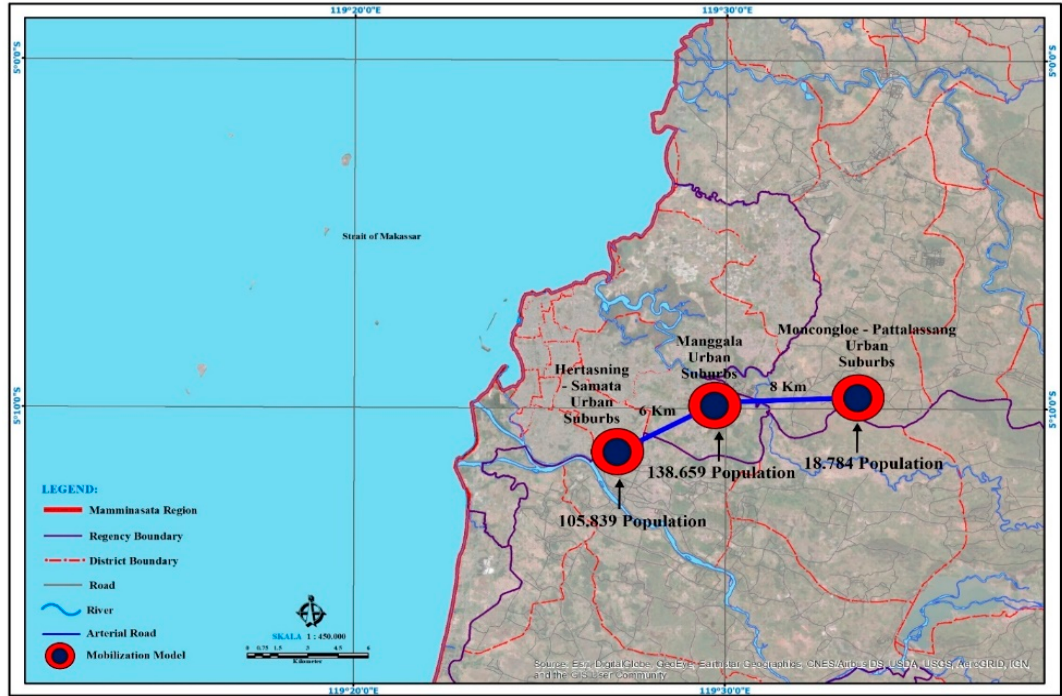
Figure 13. Example, Travel Model Average Population in the Mamminasata Metropolitan Urban Suburbs. Source: author elaboration; Folder (c) 2019 Google.